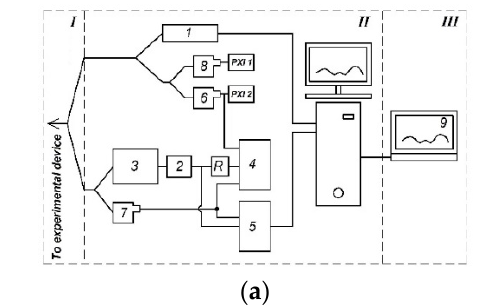
Figure 3. Optical system of facility: ( a ) scheme of optical recording system; ( b ) equipment for